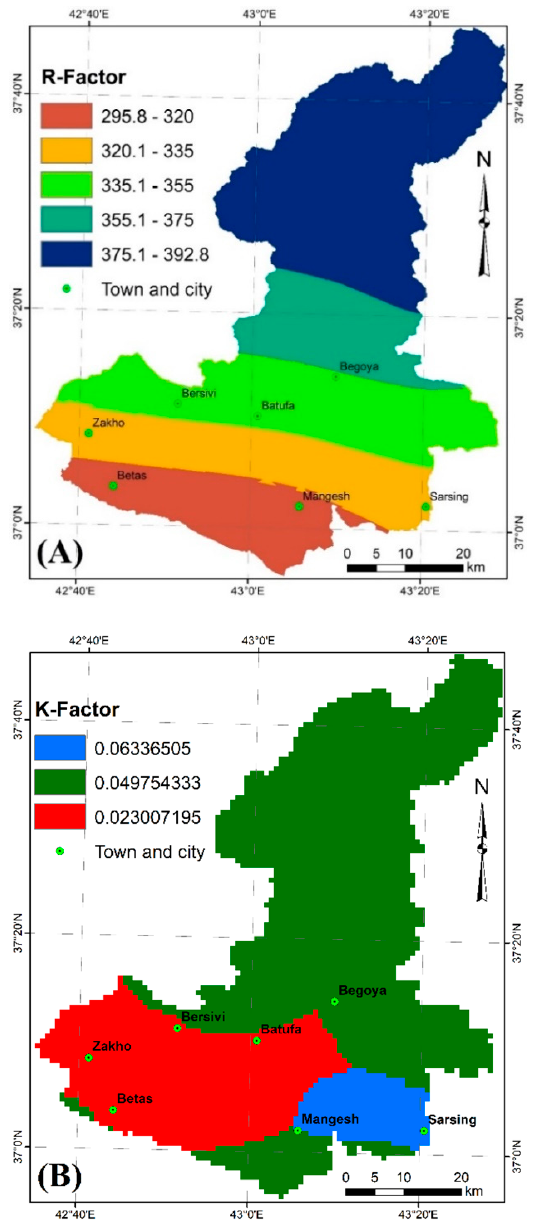
Figure 5. Maps showing the distribution of the R factor ( A ), and the K factor ( B ) within KhRB. Table 4. K factor, type, texture, and organic material content of the three soil